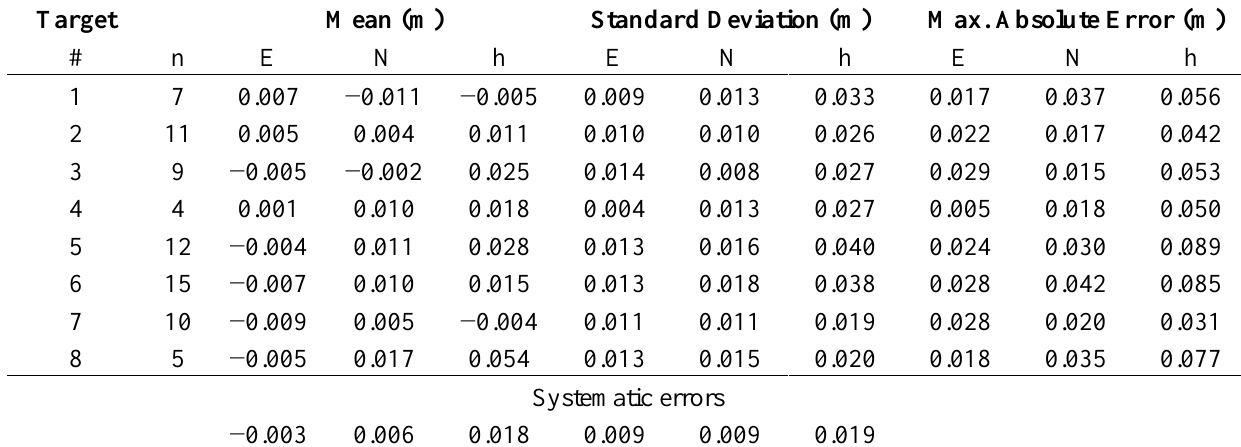
Table 4. The internal deviation of the target sphere locations computed from the Akhka MLS passes, ‗n‘ column shows the number of visibility (passes) of each target in the MLS